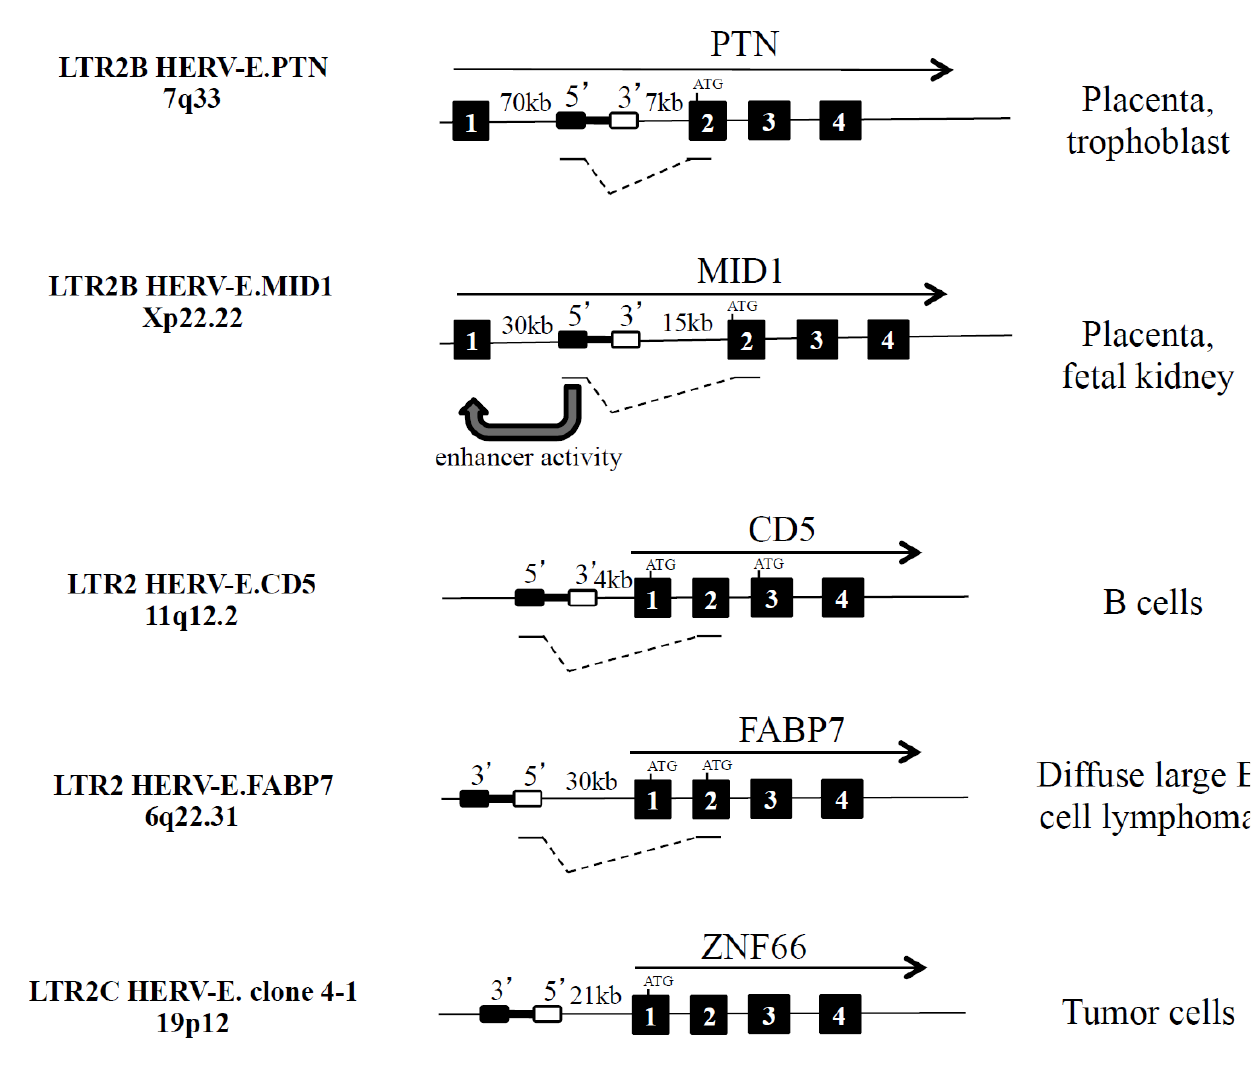
Figure 3. Examples of five integrated HERV-Es in the vicinity of PTN, MID1, CD5, FABP7 and ZNF66 human genes. HERV-E is depicted as a black rectangle (5’LTR) linked to a white rectangle (3’LTR). The direction of gene transcription is indicated (black arrow). Black boxes refer to exons, and fusion transcripts are